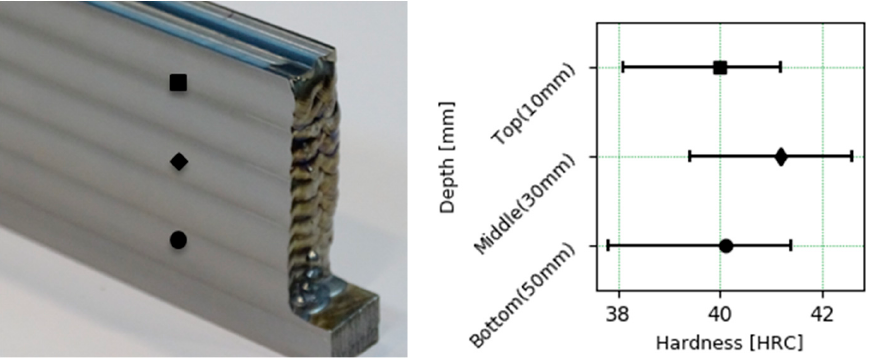
Figure 7. Hardness profiles of the walls.